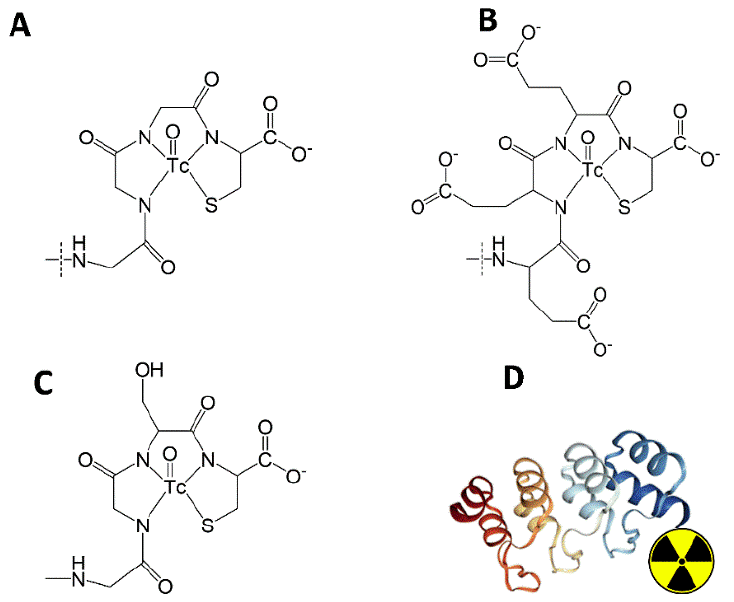
Figure 2. Schematic drawings of oxotechnetium complexes with chelating moieties of ( A ) G3-G 3 C, ( B ) G3-E 3 C, ( C ) G3-(G 3 S) 3 C, and ( D ) their position at the C-terminus of the DARPin G3.